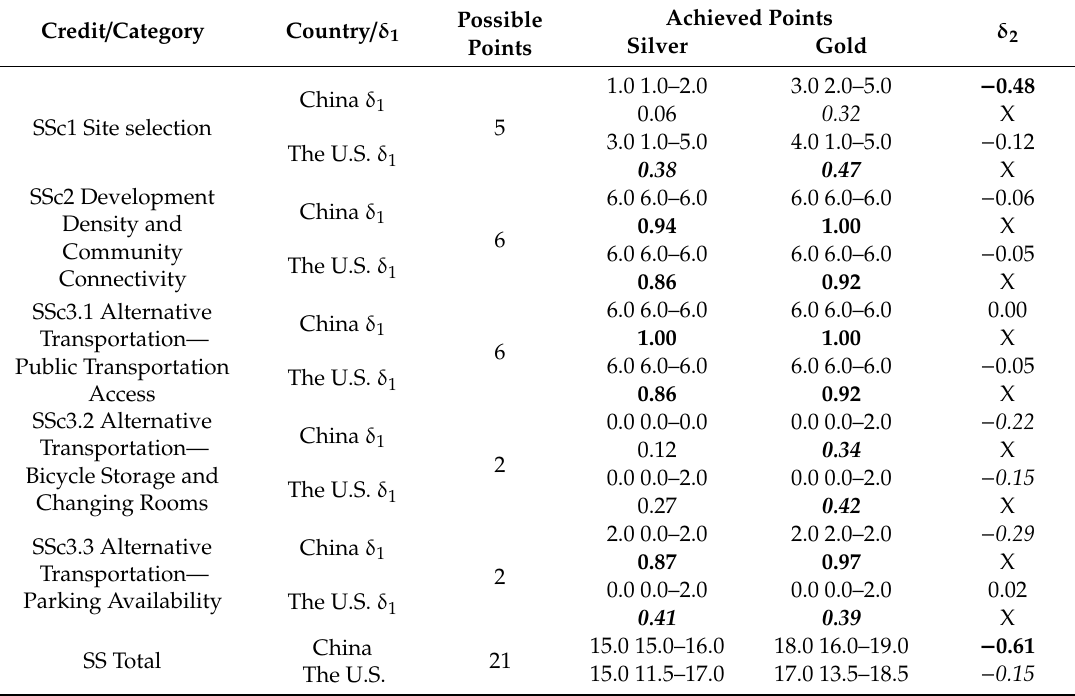
Table 2. LEED-CI v3 Sustainable Sites (SS) credits category: The median and 25th–75th centiles and Cli ff ’s e ff ect size ( δ 1 ) of the di ff erence between the achieved and the possible points, and ( δ 2 ) of the di ff erence between Silver and Gold projects in China and the U.S. Credit / Category Country / δ 1